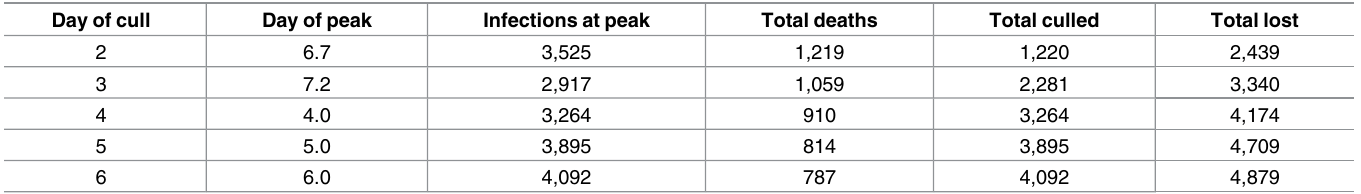
Table 5. Comparison of dynamics for targeted rapid culling, varying the day of culling. All infectiousanimalsare culled (animalsin I 1 A , I 2 , I 1 B ). One-half of infectionsare indirect ( ρ = 0.2). Total deaths are determined at t = 30 days. Day of cull Day of